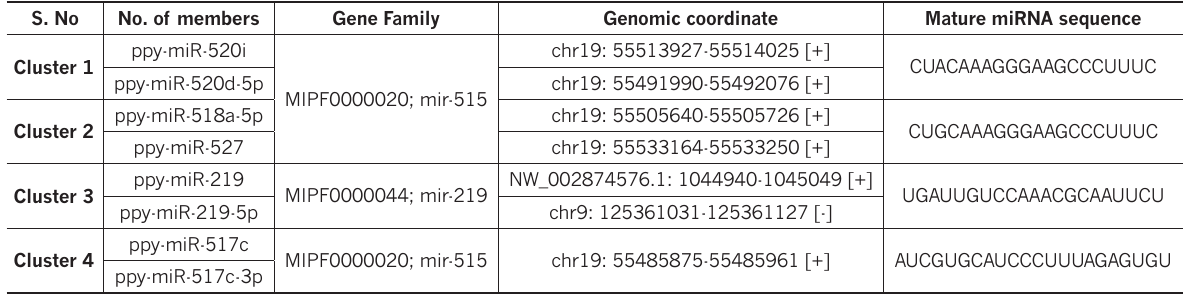
Table 3. List of miRNAs grouped into clusters, their genomic coordinates, gene family names and their matured miRNA sequences in Pongo pygmaeus .